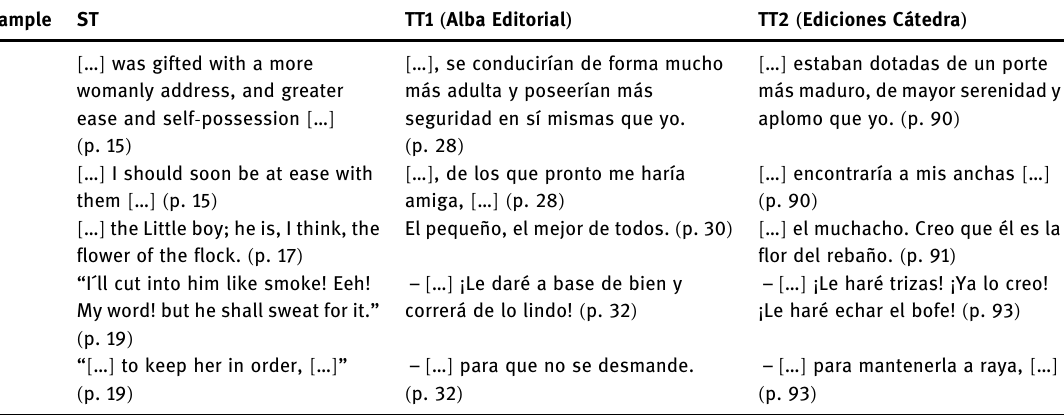
Table 2: Examples taken from Chapter 2